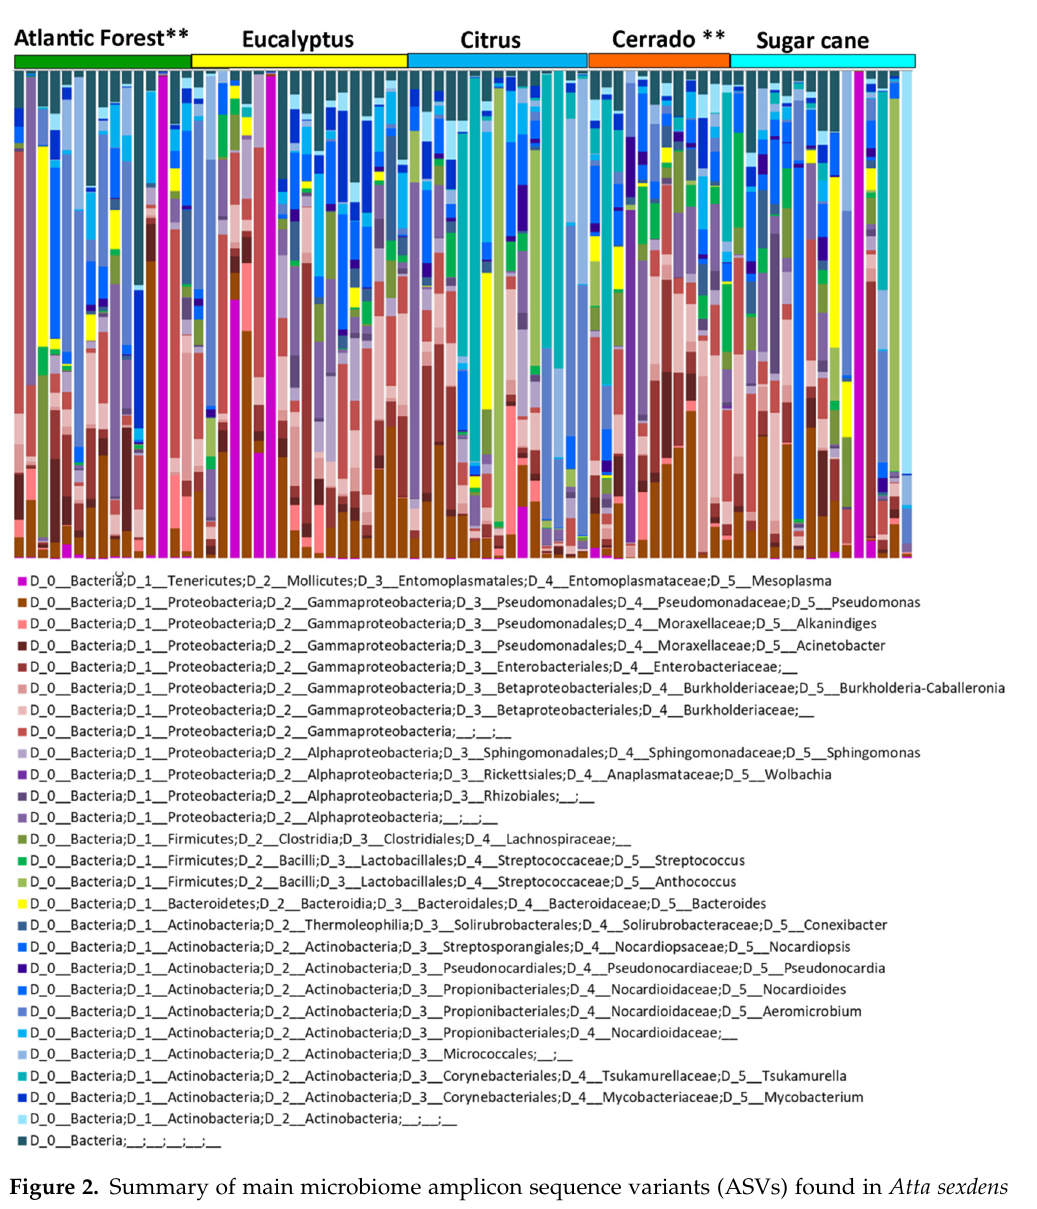
Figure 2. Summary of main microbiome amplicon sequence variants (ASVs) found in Atta sexdens with 16S rRNA amplicon sequencing. Alpha diversity of microbiota in each sample of A. sexdens . Samples were grouped according to the habitat (natural or agricultural) to which they belong. Bar graphs for each library (one column = community from a sample) show the abundance of sequence reads classified to selected 99% similarity. Each color represents a distinct bacterium. ** indicates samples in natural habitat.